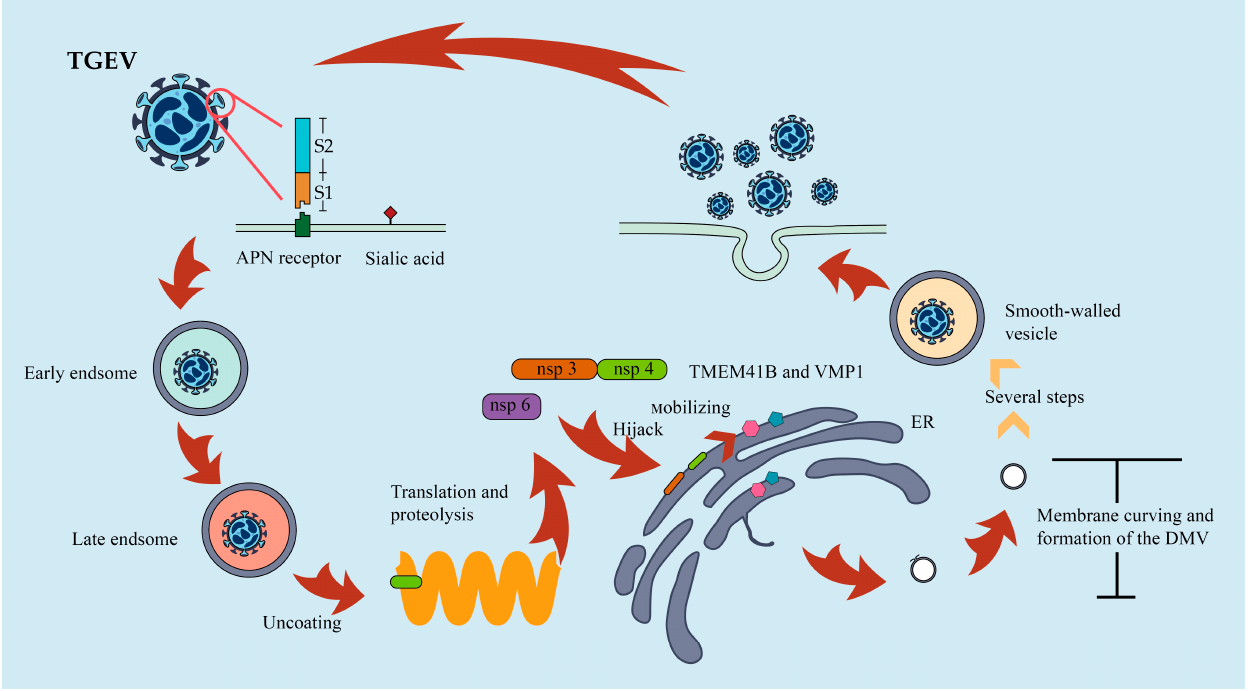
Figure 3. Schematic diagram of the role of autophagy in TGEV in infected host cells. TGEV infects host cell through the S protein recognition receptor pAPN, and this process can also be achieved by the non ‐ protein receptor sialic acid. Then, it is entered and released through the endosomal pathway. Nsp3 and Nsp4 are hydrolyzed and bound to the endoplasmic reticulum, hijacking the host endoplasmic reticulum and recruiting TMEM41B and VMP1 to form the membrane vesicles necessary for viral replication, a process that may involve Nsp6.